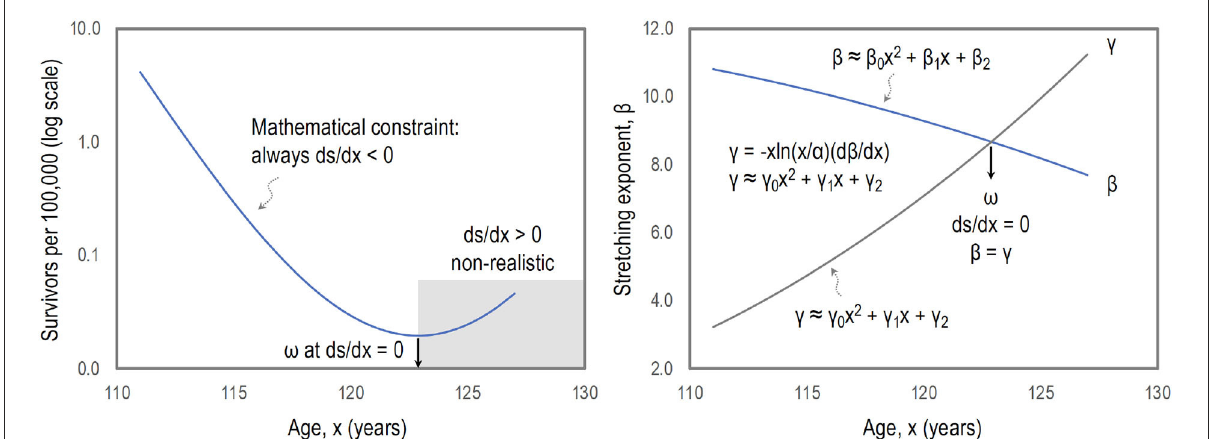
FIGURE2 Mathematical constraints of survival curves. The monotonic decrease of survival curves is inherent as ds / dx < 0, and the increase of survival curves or ds / dx > 0 is non-realistic, providing the maximum mathematical lifespan ( ω ). Defining ω at ds / dx = 0, which is equivalent to β ( x ) = γ ( x ) for the modified stretched exponential model, we are able to estimate ω at the crossover of the plausible quadratic models of β ( x ) and γ ( x